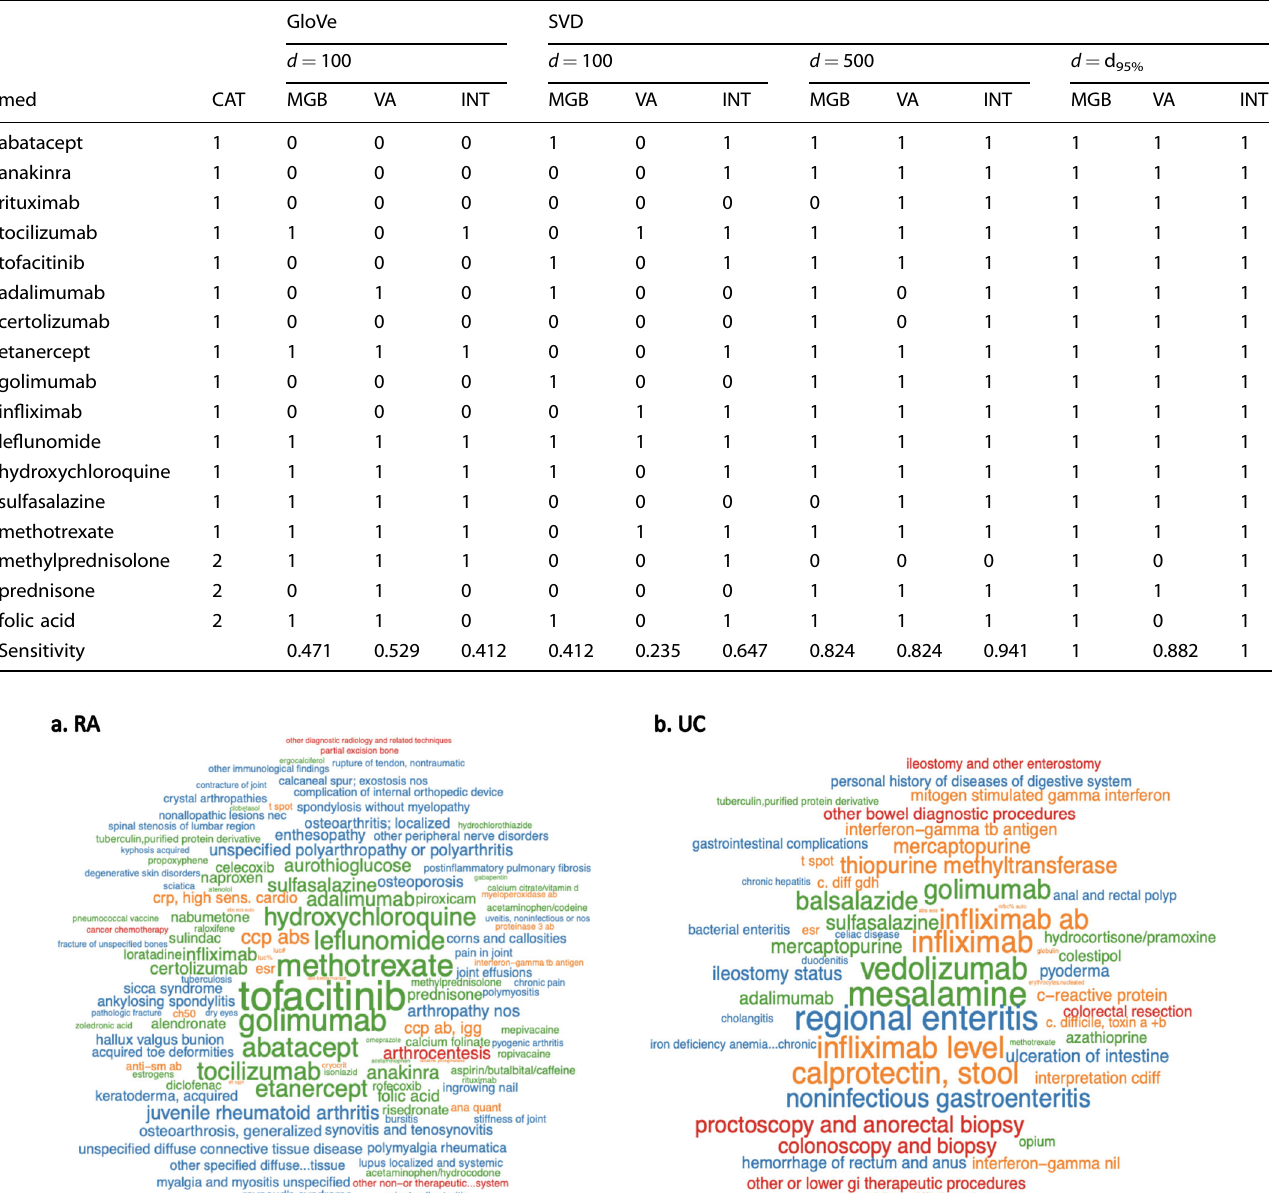
Table 3. Sensitivities of KESER MGB (MGB), KESER VA (VA), and KESER INT (INT) in detecting two categories (CAT) of RA-related medications. CAT = 1 for DMARDs in use and CAT = 2 for other drugs often used to manage RA patients.